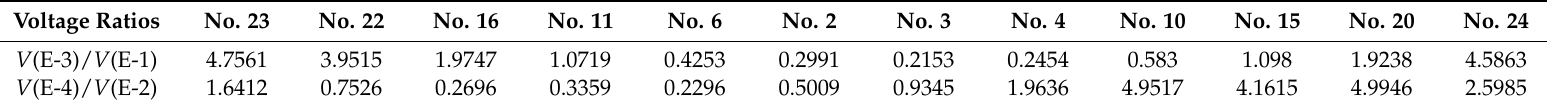
Table 5. Voltage ratios of No. 23 to No. 24 with a